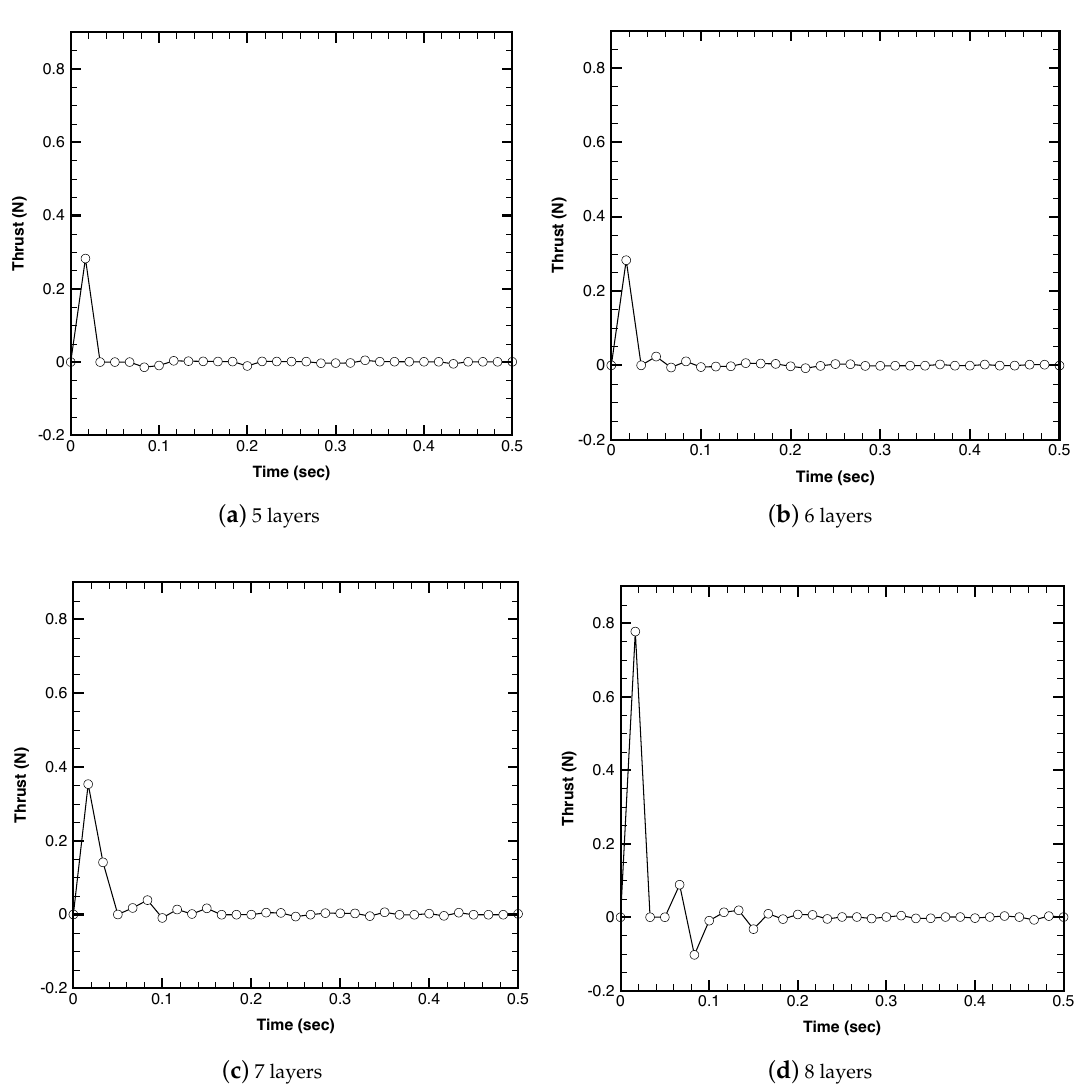
Figure 9. Thrust profiles obtained from cart velocity measurements after the disc rupture for 5–8 aluminum layers, corresponding to different burst pressures. The aluminum layers have an average thickness of 0.016 mm. Each curve represents the ensemble average of four trials. The results show there is a sharp spike in thrust followed by a rapid decrease thereafter. Note also the presence of negative thrust values; this is addressed in Section